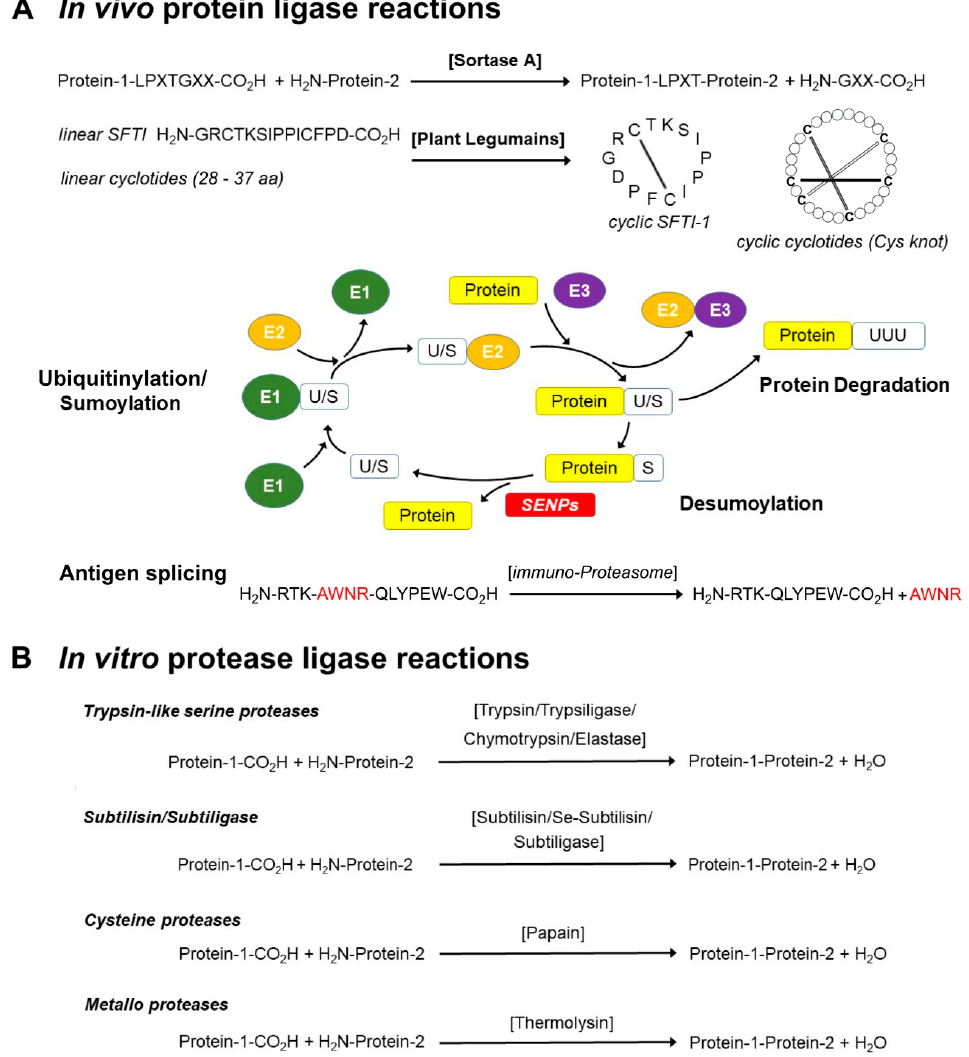
Figure 1. Overview of Proteases/Ligases in Biology and Organic Synthesis. ( A ) Natural processes involving protein ligases. Cyclotides are 28 to 37 amino acids (aa) long. Ubiquitinylation and sumoylation require the specialized ligases E1, E2, and E3, being various enzymes in both pathways. E1 utilizes ATP hydrolysis for the formation of thioesters with the C-terminus of ubiquitin (U) or SUMO (S) and transfers them to E2 as thioesters. Eventually, up to 1000 specialized E3 ligases, such as the numerous really interesting new gene (RING) finger domain ligases, form isopeptide bonds between U/S and Lys side-chains of target proteins. Whereas polyubquitinylated proteins are degraded by proteasomes, several sentrin-specific proteases (SENPs) cleave the SUMO tags in regulatory processes. ( B ) Synthetic approaches using various proteases and their engineered